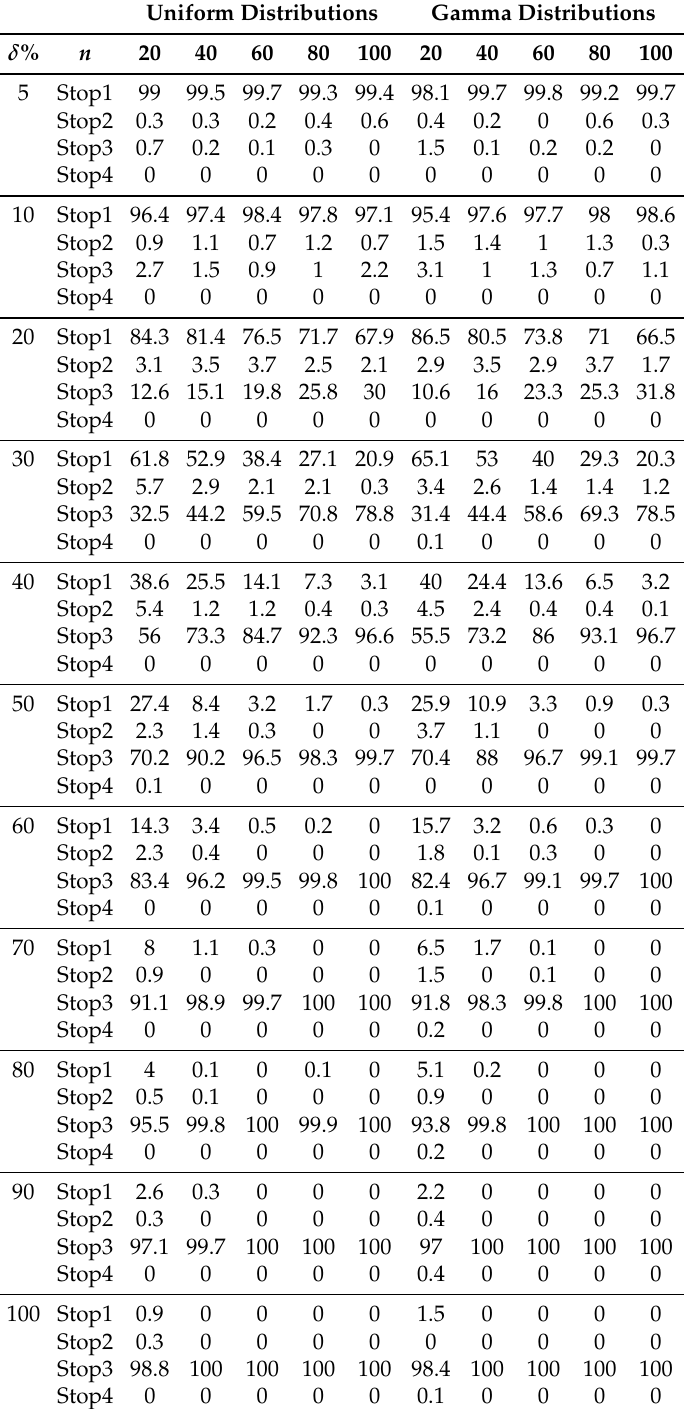
Table A6. Computational results for randomly generated instances with the ratio 5%:5%:5%:85% of the numbers of jobs in the subsets J 1 , J 2 , J 1,2 and J 2,1 of the job set J